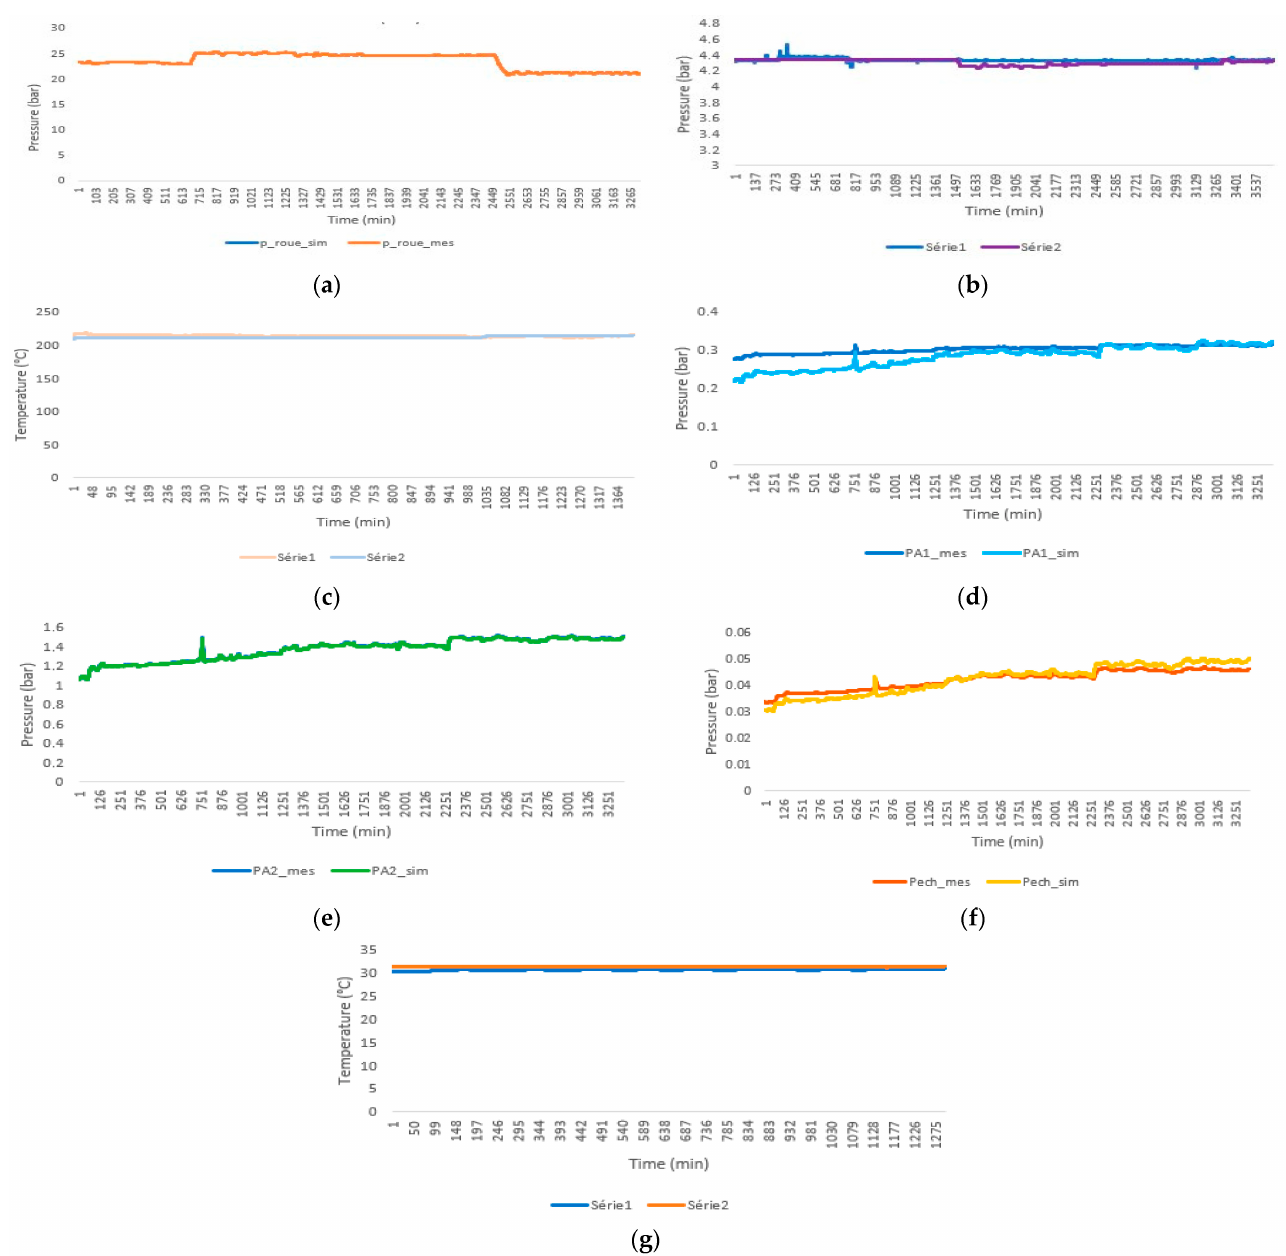
Figure 16. Admission stage pressure. ( a ) HP section pressure. ( b ) HP section